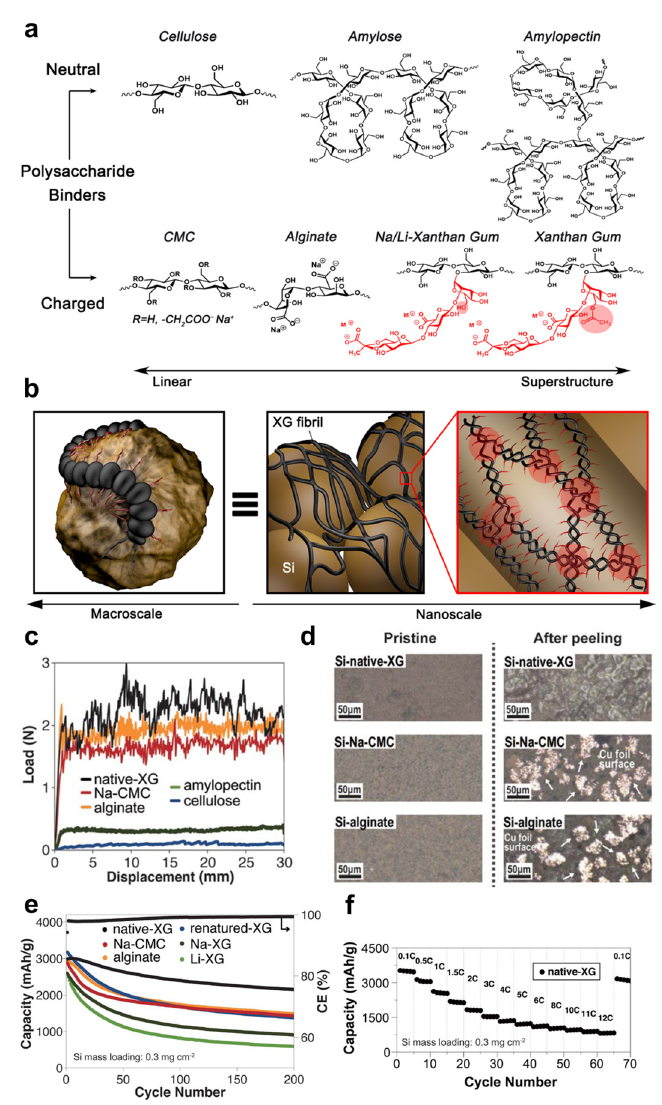
Figure 2. ( a ) Chemical structures of various neutral and charged polysaccharide binders, ranging from cellulose to XG. ( b ) Wide-scale illustration of role of XG in contributing to strong adhesion to Si, through a series of multiple short side chains in native XG (colored in red). ( c ) Film adhesion tests (peeling test) based on different binders. ( d ) Optical images for different binders before and after peeling. ( e ) Cycle retention and ( f ) rate capabilities tests of Si electrode with XG binder [43]. Along with this inspiring work came a number of more updated studies utilizing natural gum as a functional binder together with Si and other anode materials. For